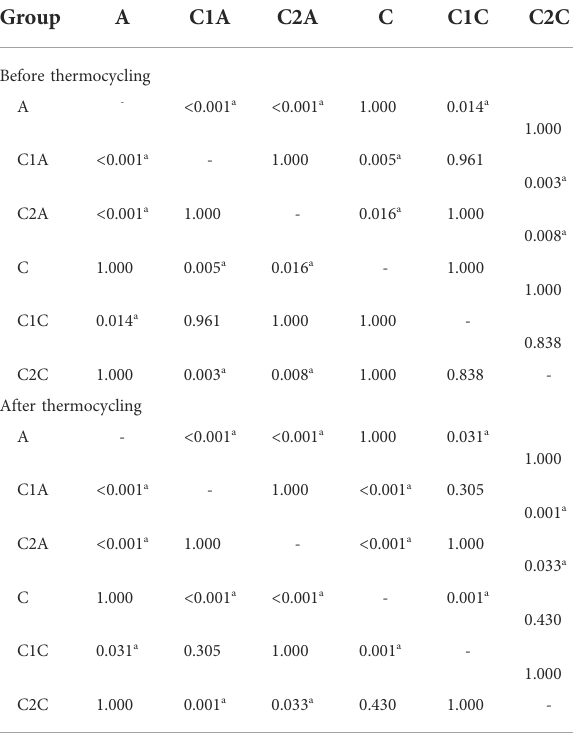
TABLE 4 Post hoc comparisons of the adhesive remnant index scores before and after 10,000 thermocycles.